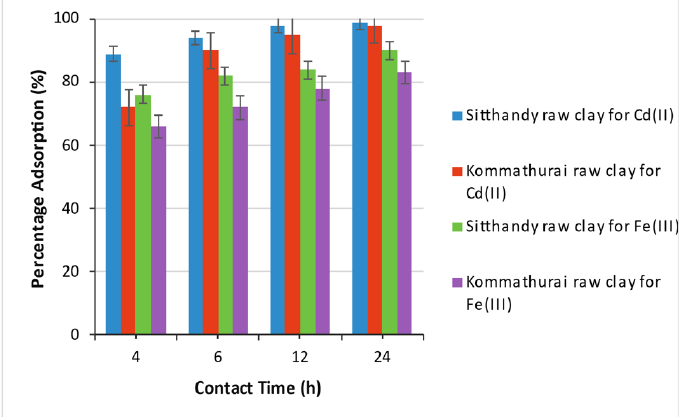
Figure 4: Effect of contact time on adsorption of different heavy metal ions (Initial metal ions concentrations 100 mg L -1 ).